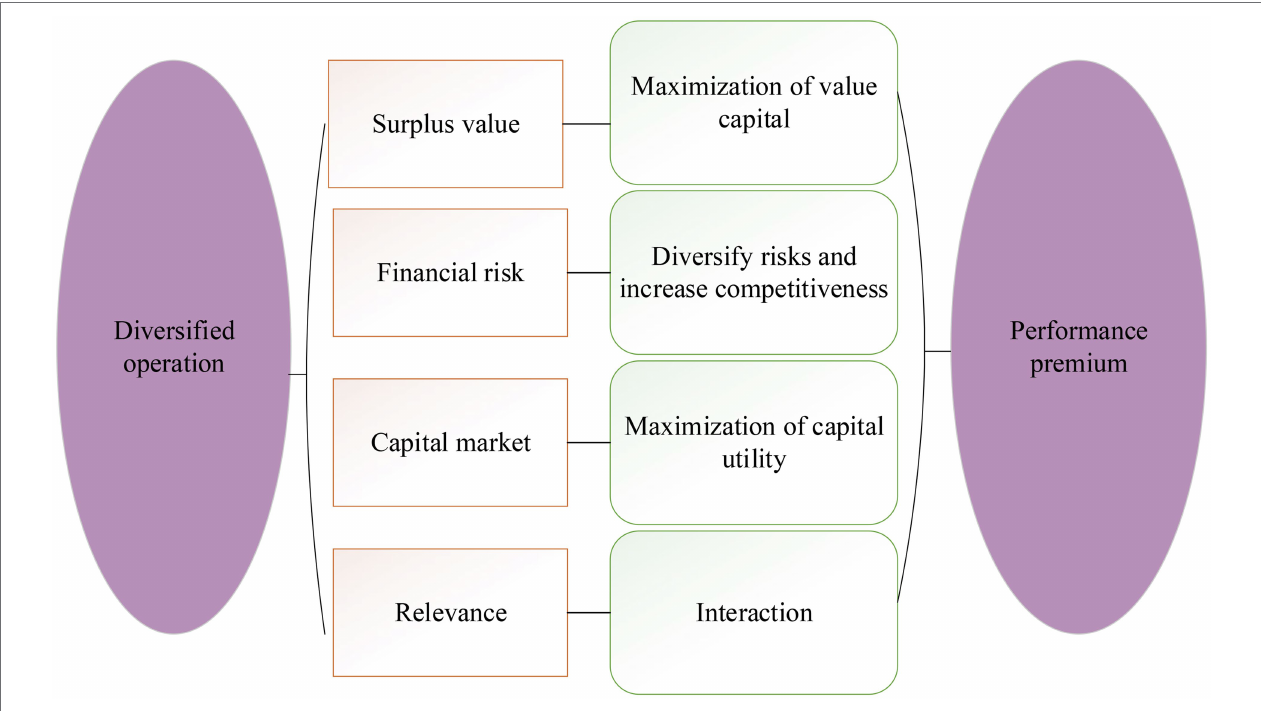
FIGURE 5 | Positive impact of diversification.